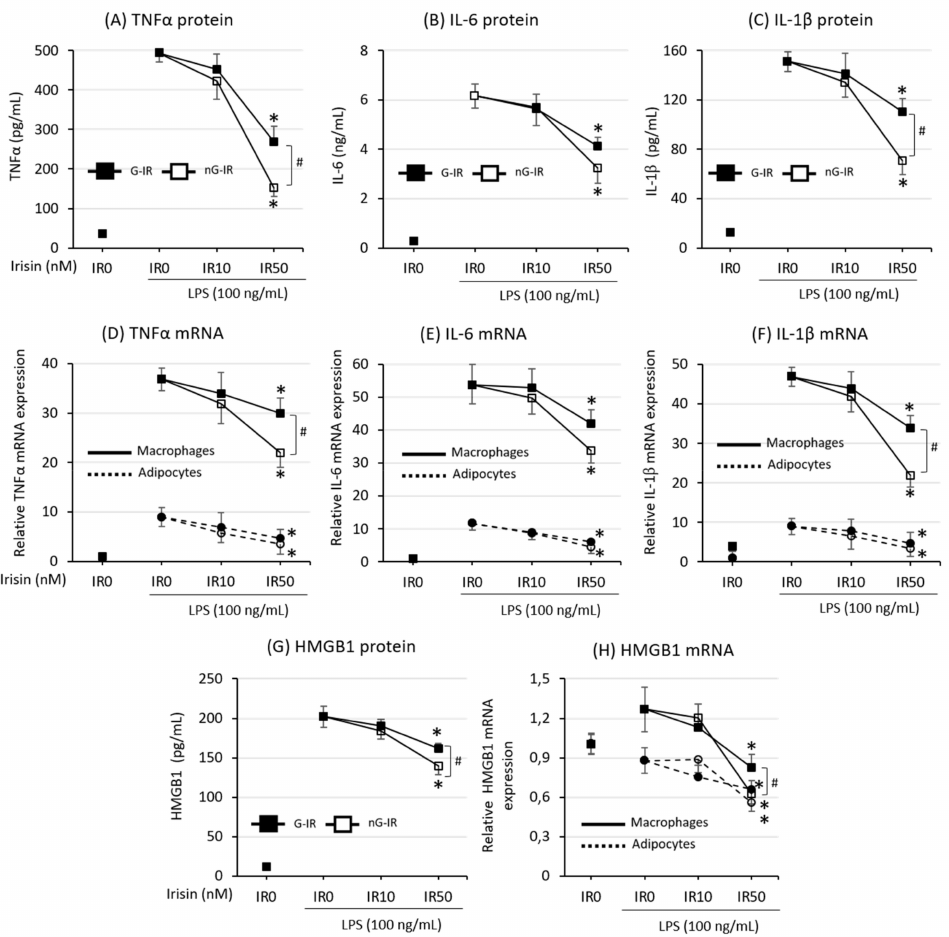
Figure 2. E ff ects of various forms of irisin (glycosylated (G-IR) or non-glycosylated (nG-IR)) on lipopolysaccharide (LPS)-induced cytokine release: tumor necrosis factor-alpha (TNF- α ) ( A ), interleukin 6 (IL-6) ( B ), and interleukin 1 β (IL-1 β ) ( C ). Cytokine mRNA expression: TNF- α ( D ), IL-6 ( E ), IL-1 β ( F ), as well as high-mobility group box-1 protein (HMGB1) release ( G ) and HMGB1 mRNA expression ( H ), by adipocyte–macrophage cocultures. Fully di ff erentiated 3T3 L1 adipocytes and RAW 264.7 macrophages were cultured in 12-well dishes with inserts (0.4- µ m pore size) for 6 h (mRNA expression, RT-PCR) or 24 h (cytokine release, ELISA tests) with or without the presence of irisin (0, 10, or 50 nM) administered 2 h before LPS stimulation (100 ng / mL). The results are expressed as mean + standard deviation (SD) from five independent experiments. Statistical significances ( p < 0.05) were determined with the Duncan t -test. The asterisk (*) above the bar denotes statistically significant di ff erences in protein or mRNA level calculated relative to the IR0 group, while the hash (#) denotes statistically significant di ff erences calculated between the G-IR and the nG-IR